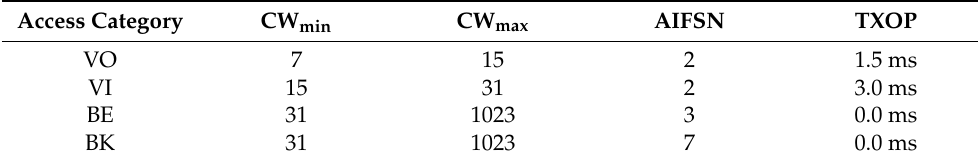
Table 1. Default EDCA ACs